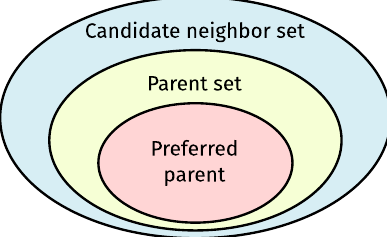
Figure 1. Relationship between three logical Routing Protocol for Low-power and Lossy Networks (LLNs) (RPL) sets tracked by each network node. Note that the formation of these sets is governed by the RPL Objective Function (OF) tied to the RPL instance to which a given node belongs.